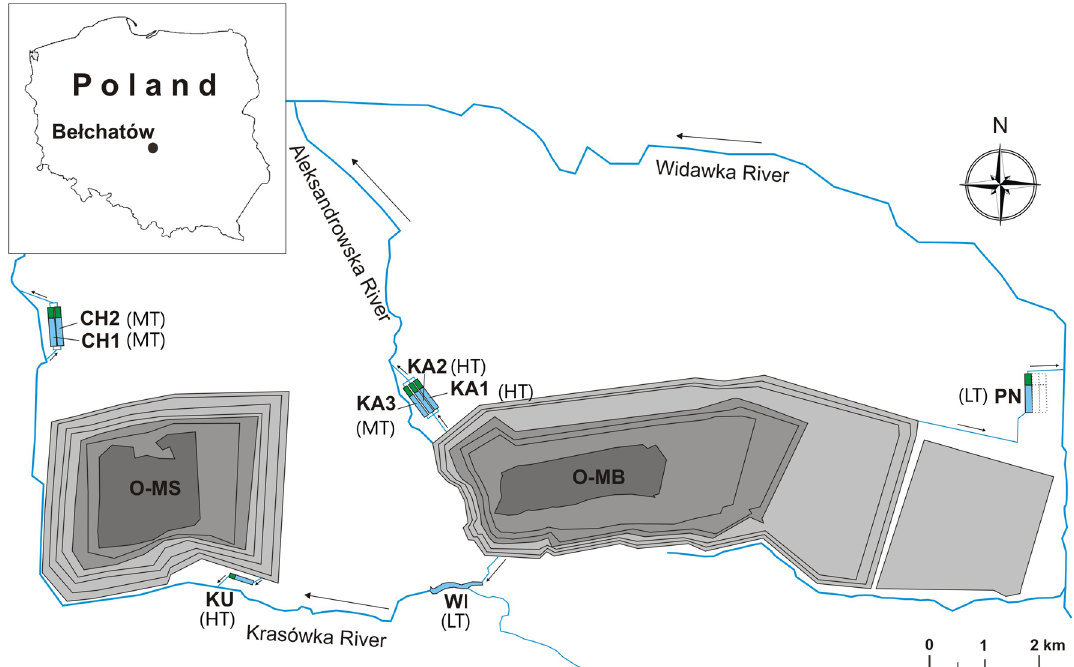
Figure 4. Location of the study area. O-MB opencast mine in Bełchatów, O-MS opencast mine in Szczerców; reservoirs CH1, CH2, and KA3 represent the MT class; reservoirs KA1, KA2, and KU represent the HT class; reservoirs PN, WI represent the LT class. Modified, see 37